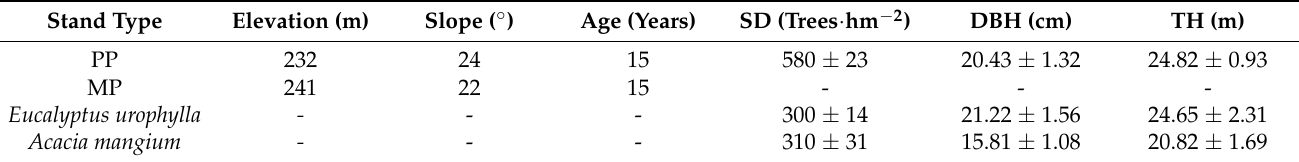
Table 1. Main properties of the two experimental stands (mean ± standard error, n =